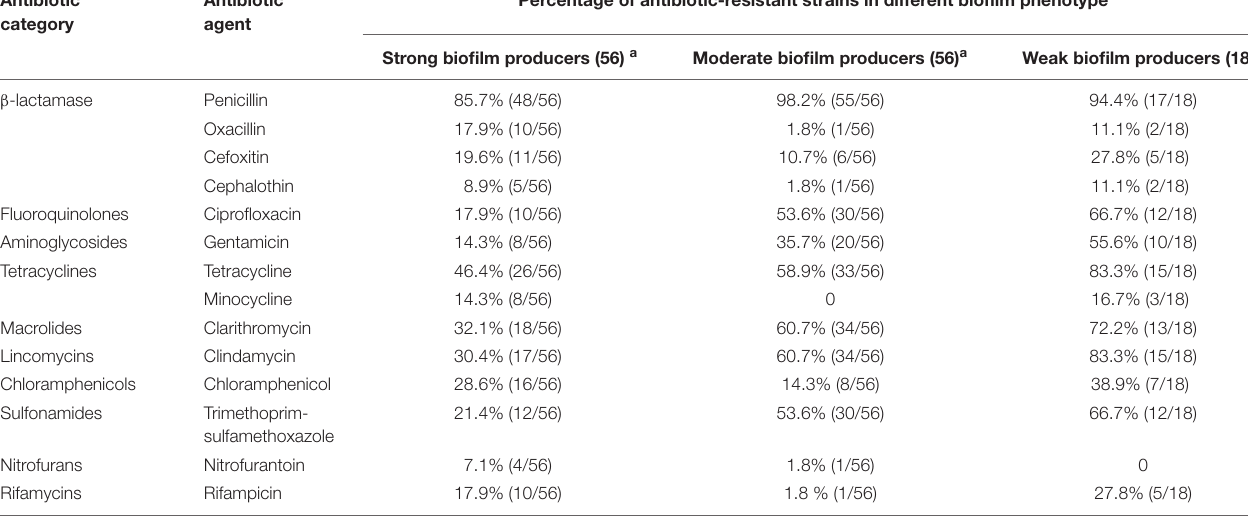
TABLE 6 | Biofilm formation and antibiotic resistance pattern of 130 S. aureus isolates from different stages of pork production. Antibiotic category